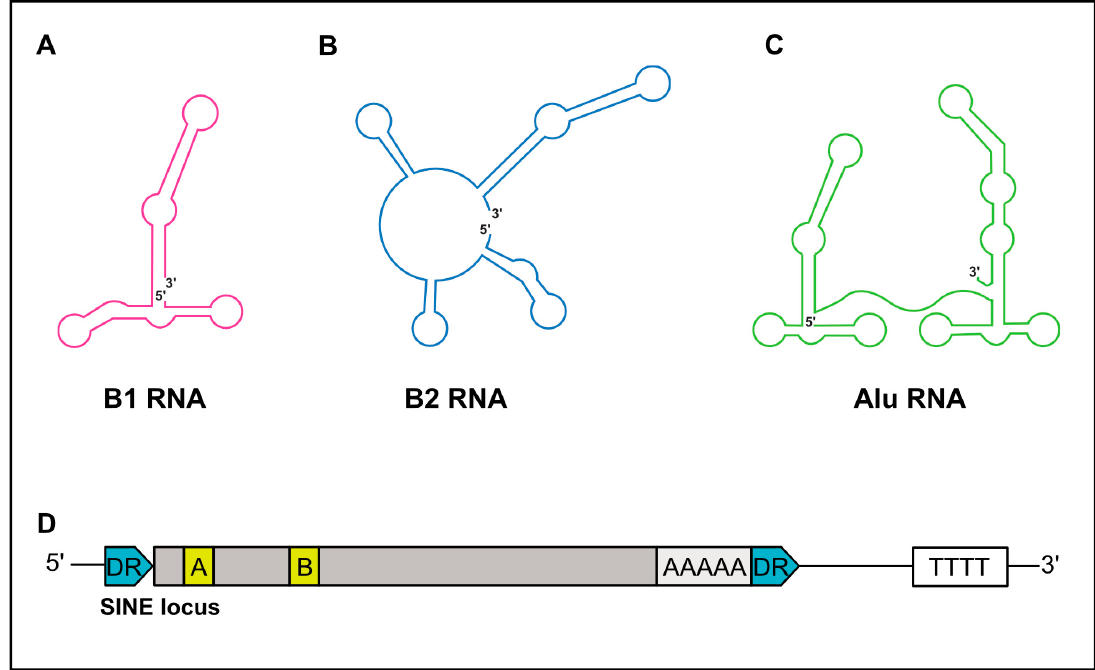
Figure 2. Schematic structures of SINE RNA and genomic loci. ( A ) Schematic secondary structures of B1 RNA, ( B ) B2 RNA, and ( C ) Alu RNA. 5 ′ and 3 ′ ends of RNA are denoted. ( D ) Depiction of a SINE genomic locus. SINEs are flanked by direct repeats (DRs, in blue). SINEs are driven by a type II RNA polymerase (RNAP) III promoter, within internal A and B boxes (yellow). A poly A sequence is often near the 3 ′ -end. Transcription termination occurs at a downstream poly (T) sequence. Grey boxes represent the remaining SINE sequence.